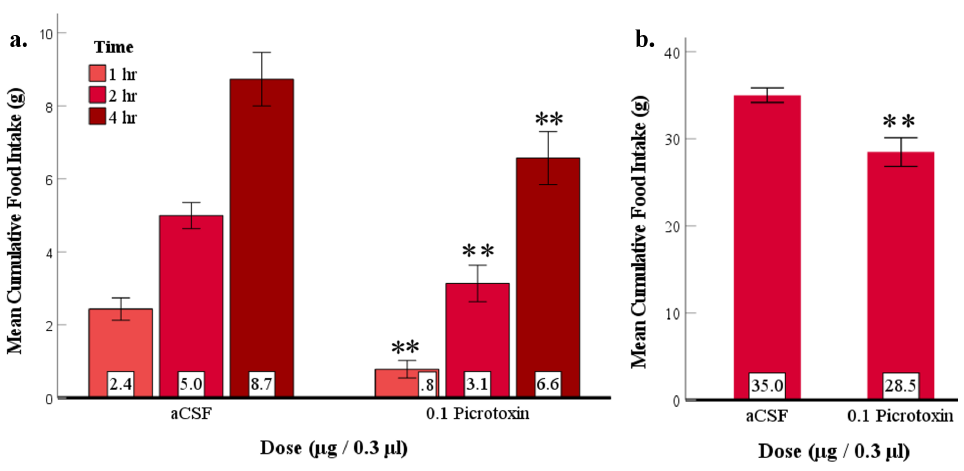
Figure 6. Picrotoxin injected into the LS at the beginning of the dark phase suppressed naturally occurring nocturnal feeding. Error bars: ±SEM; n = 11; mean values are shown at the bottom of the bar. ** indicates significant differences ( p < 0.01) compared to the aCSF condition at matched times. ( a ) Picrotoxin supressed feeding at 1, 2, and 4 h after injection. ( b ) Picrotoxin continued to suppress feeding at the 24 h